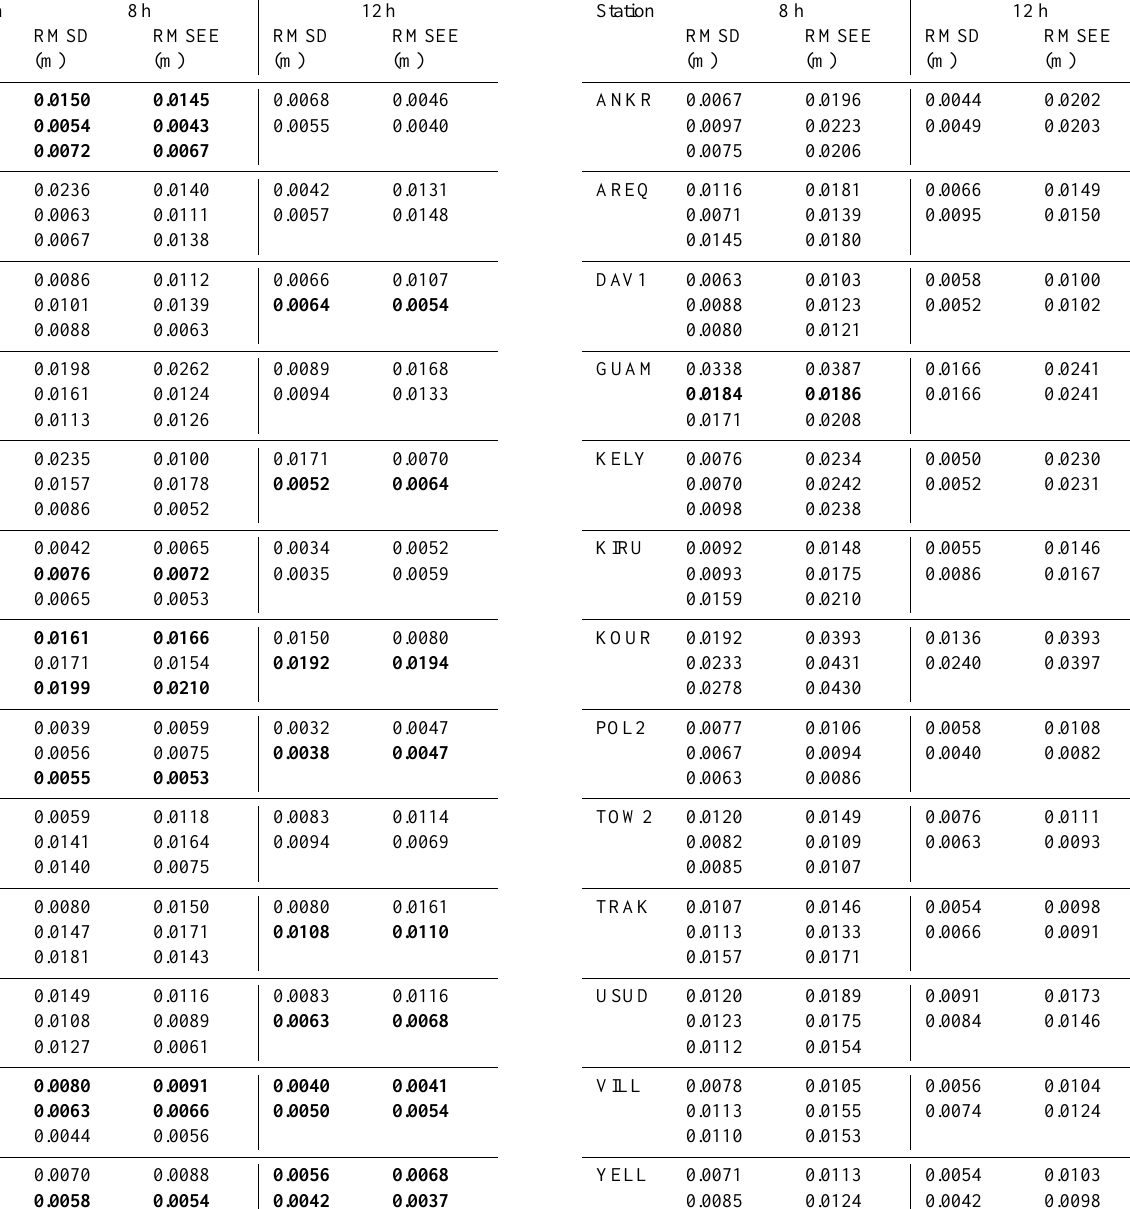
Table 7. Testing whether RMSEEs from individual longitudinal short session regression models are identical to RMSDs formed us- ing 24h solutions as the truth (1mm threshold is used). The identi- cal solutions are shown with bold numbers.